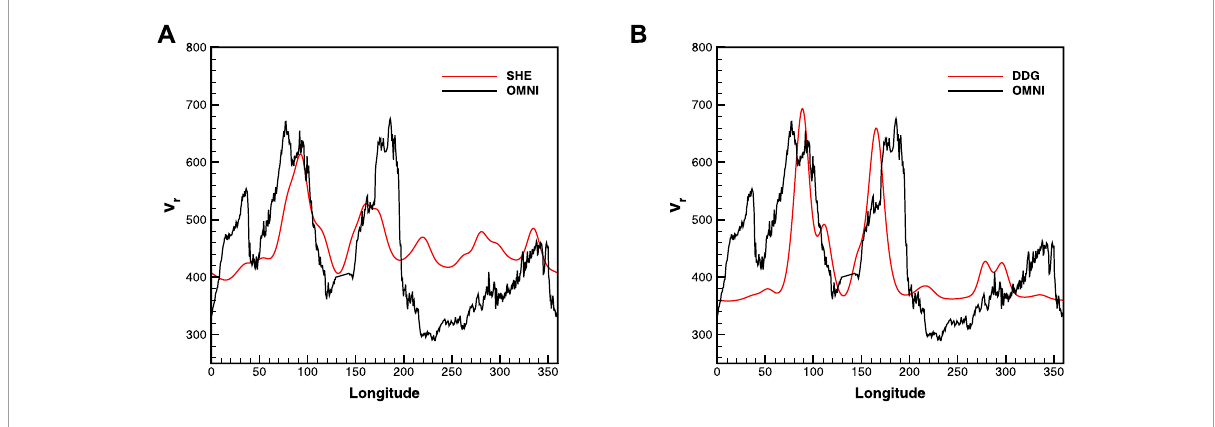
FIGURE 9 Comparisons between the interplanetary measurements from OMNI and the modeled radial velocity v r (km/s) based on the SHE solver (A) as well as the DDG-PFSS solver (B) .